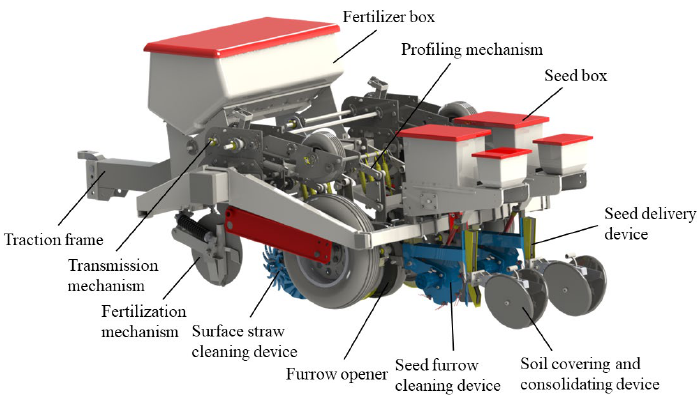
Figure 2. Structure of maize no-till seeder.